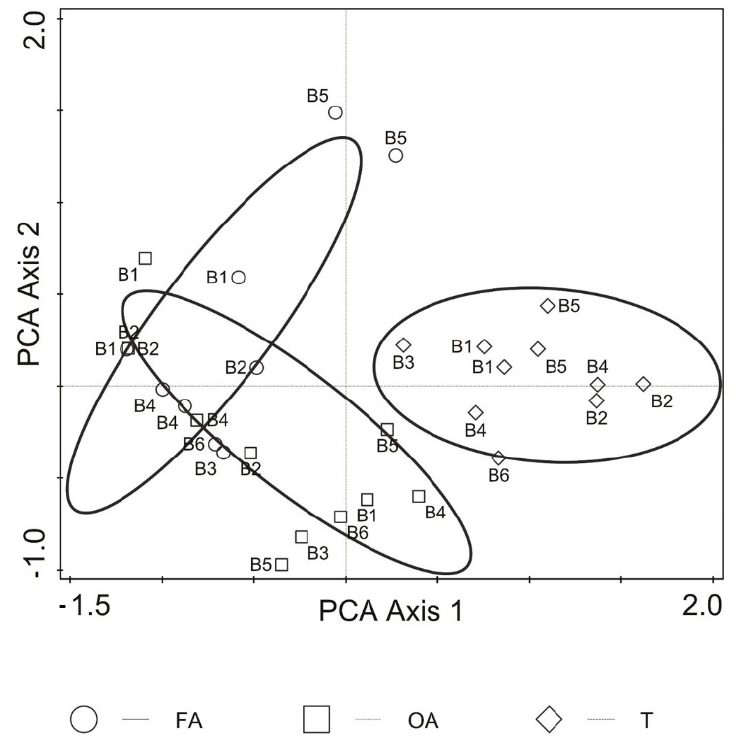
Figure 2. Non-metric multidimensional scaling (NMDS) results of Collembola community distribu- tion pattern amongst study habitats (H) and location (B) of the Barents Sea. FA: alive macroalgae, OA: aged macroalgae, T: coastal tundra; digits 1–6 at variant symbols denote replication of sites (B) across time (2010 and 2013 seasons). NMDS model calculated with Bray–Curtis dissimilarity measure. Axes I and II rotated by applying principal component analysis (PCA) and 37